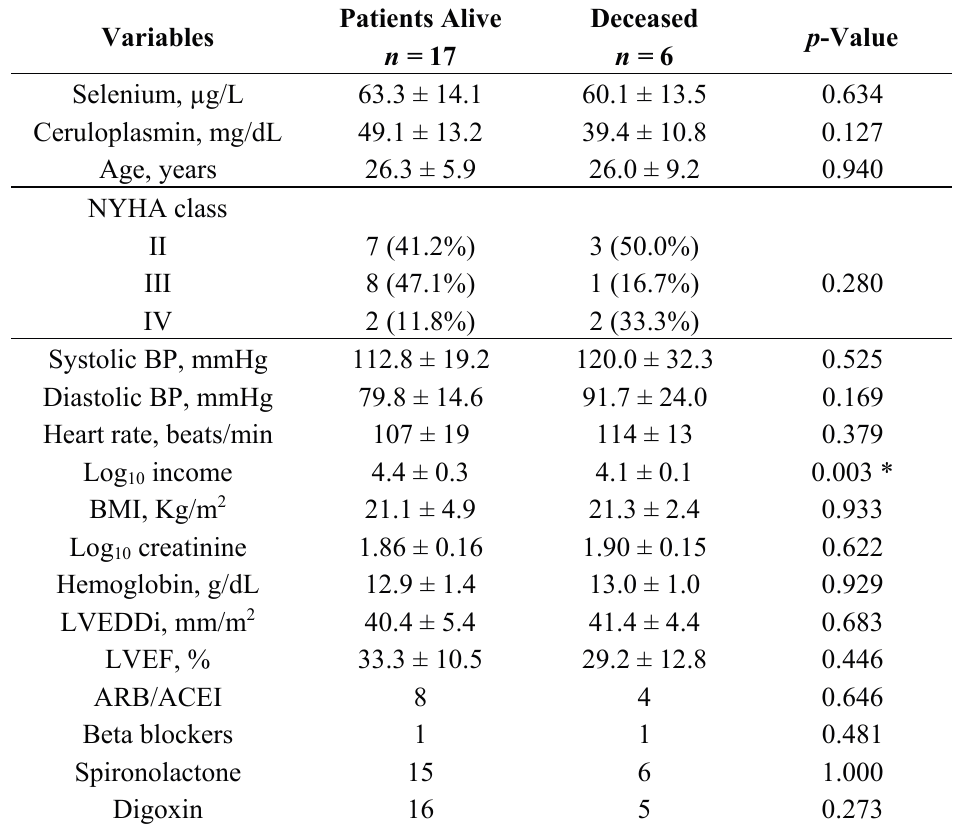
Table 3. Baseline characteristics of patients alive and the deceased at six-month follow-up.